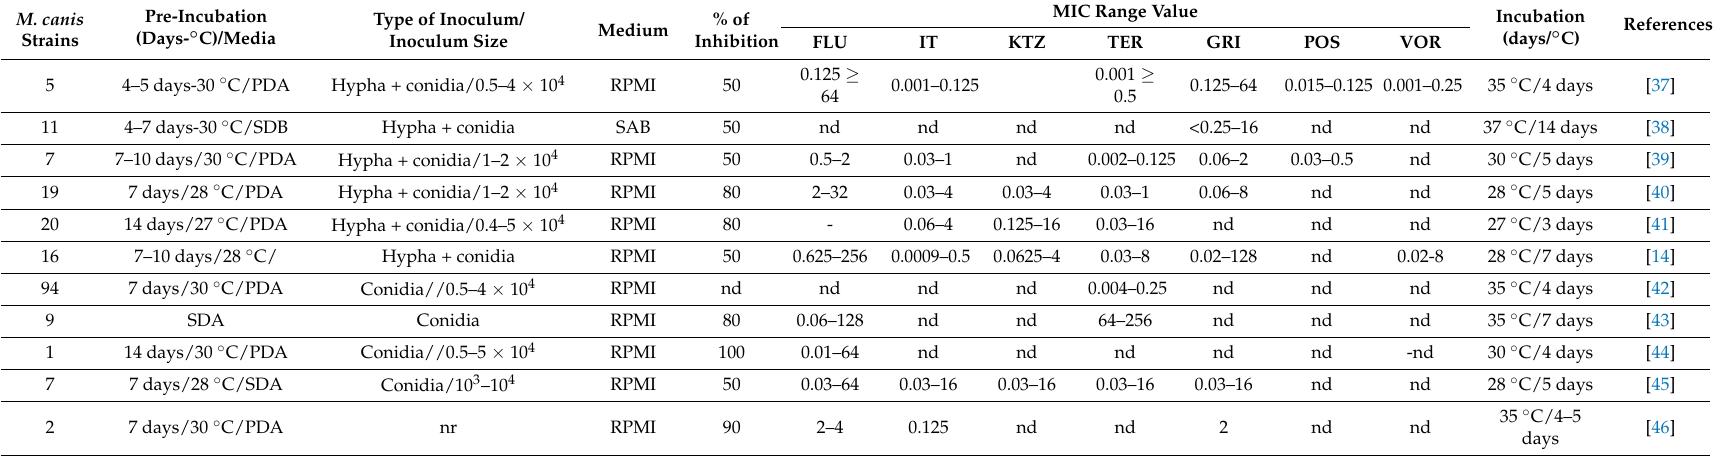
Table 2. CLSI procedures for antifungal susceptibility in Microsporum canis . Range of MIC values ( µ g/mL) of azoles, griseofulvin, and terbinafine were also reported.